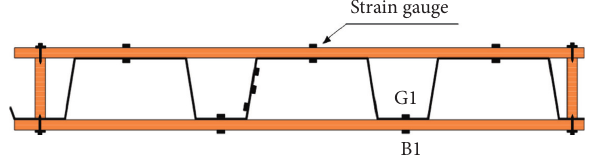
Figure 6: The positions of strain gauges.